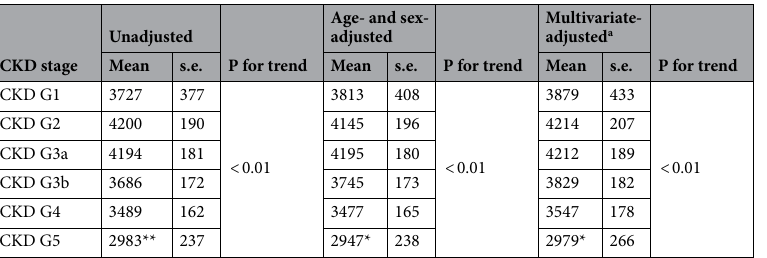
Table 6. Association between CKD stage and amount of β carotene consumed per day. CKD, chronic kidney disease; s.e., standard error. **P < 0.01 vs mean value of CKD G1, *P < 0.05 vs mean value of CKD G1. a Adjusted for age, sex, diabetes, history of cardiovascular disease, systolic blood pressure, body mass index, serum albumin concentration, low-density lipoprotein cholesterol, log-C-reactive protein, and urinary protein/ creatinine ratio.